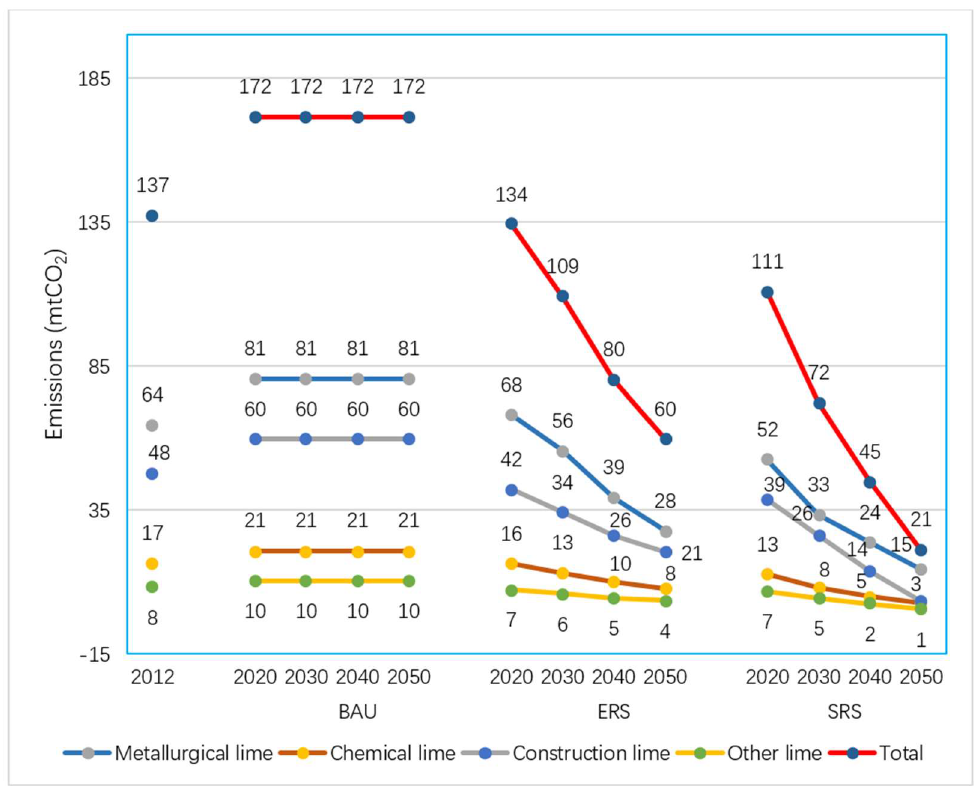
Figure 4. CO 2 emissions from lime production in each scenario.